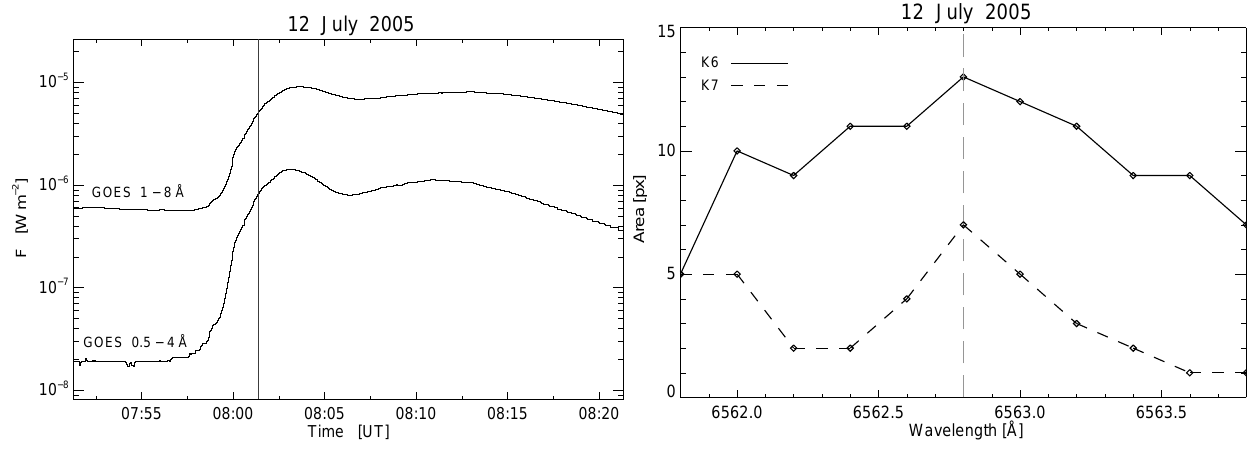
Fig. 6. Areas of the K6 and K7 flaring kernels of the C8.3 class solar flare at 08:01:22UT on 12 July 2005. The left and right panels are the same as on Fig.